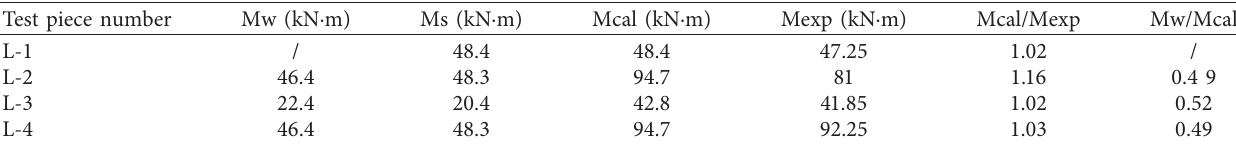
Table 6: Comparison of bending bearing capacities between calculation and test results. Test piece